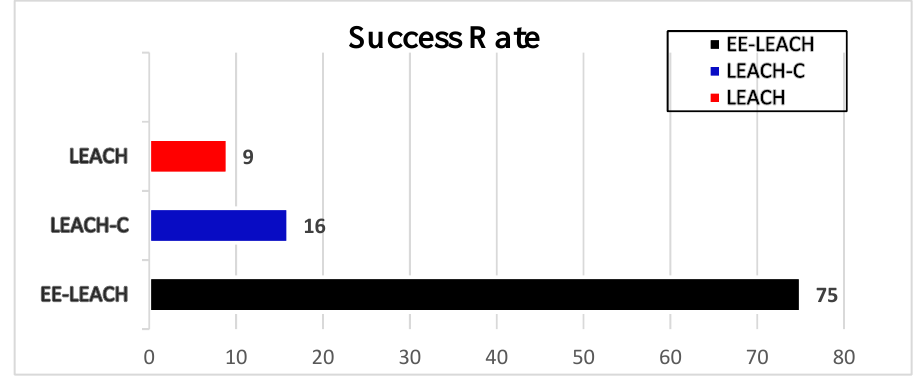
Figure 11. Packet success ratio.